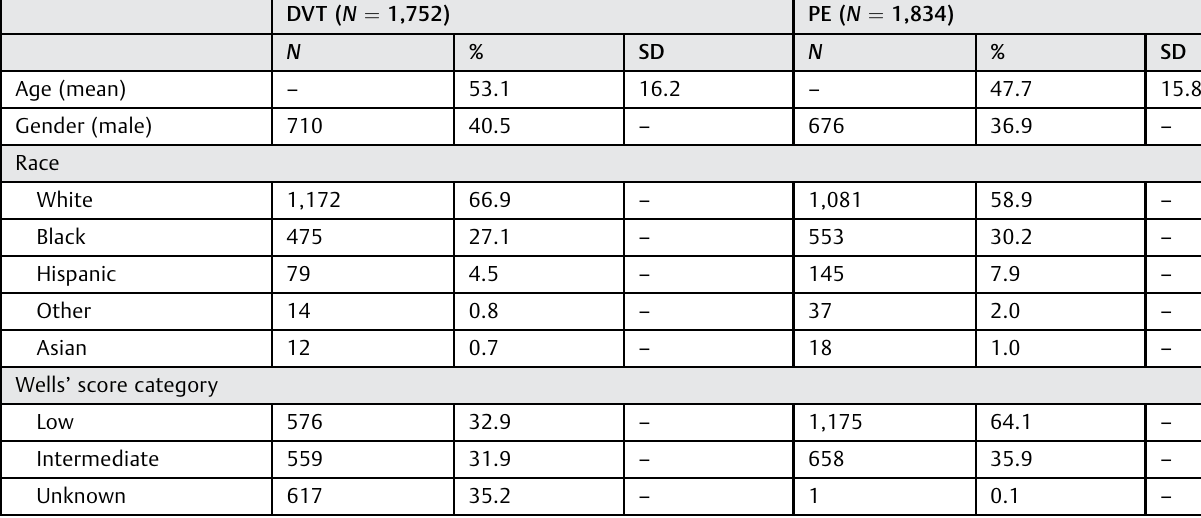
Table 1 Characteristics of patients evaluated for